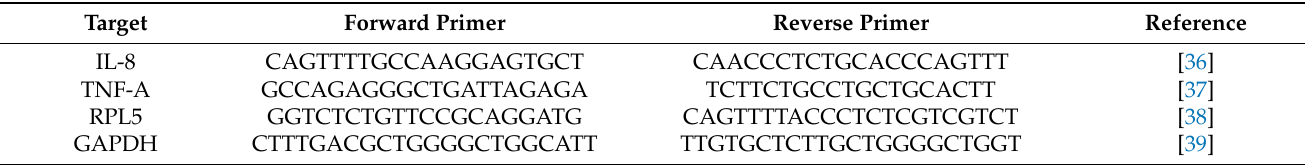
Table 2. Primer design for PCR